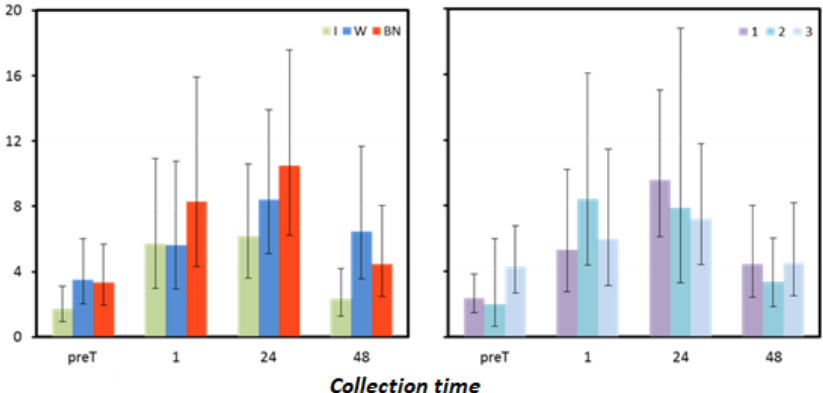
Figure 7. Interleukin mean values estimated via the least squares method with upper and lower confidence intervals for four measurements [pg · mL − 1 ].